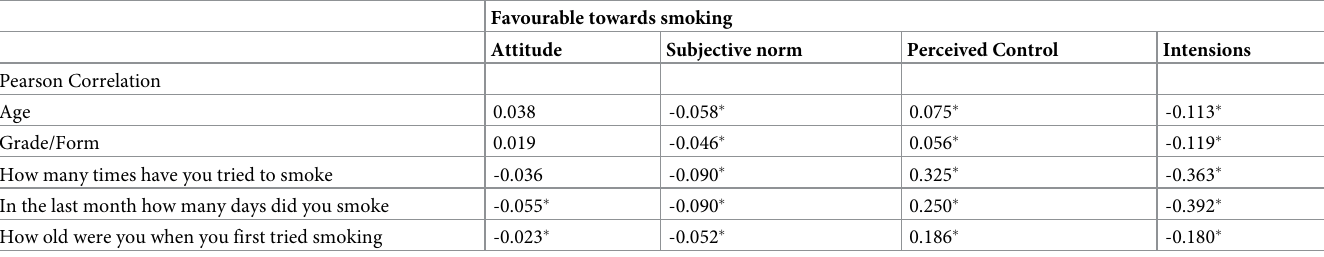
Table 4. Associations between TPB’s constructs and background